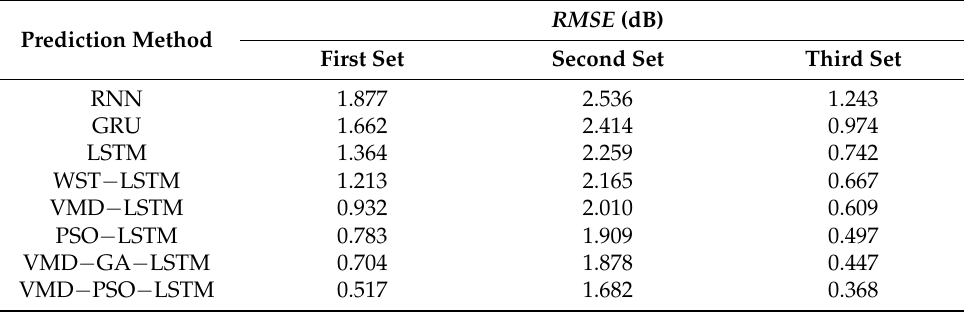
Figure 16. Prediction results of the third set of PL for different methods. Table 10. RMSE of different prediction methods for three sets of PL sequences.